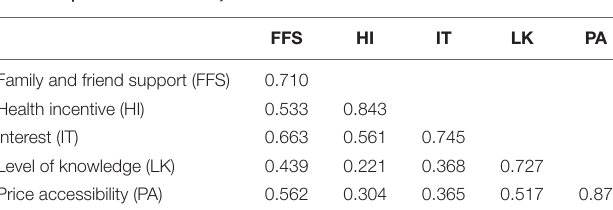
TABLE 2 | Discriminant